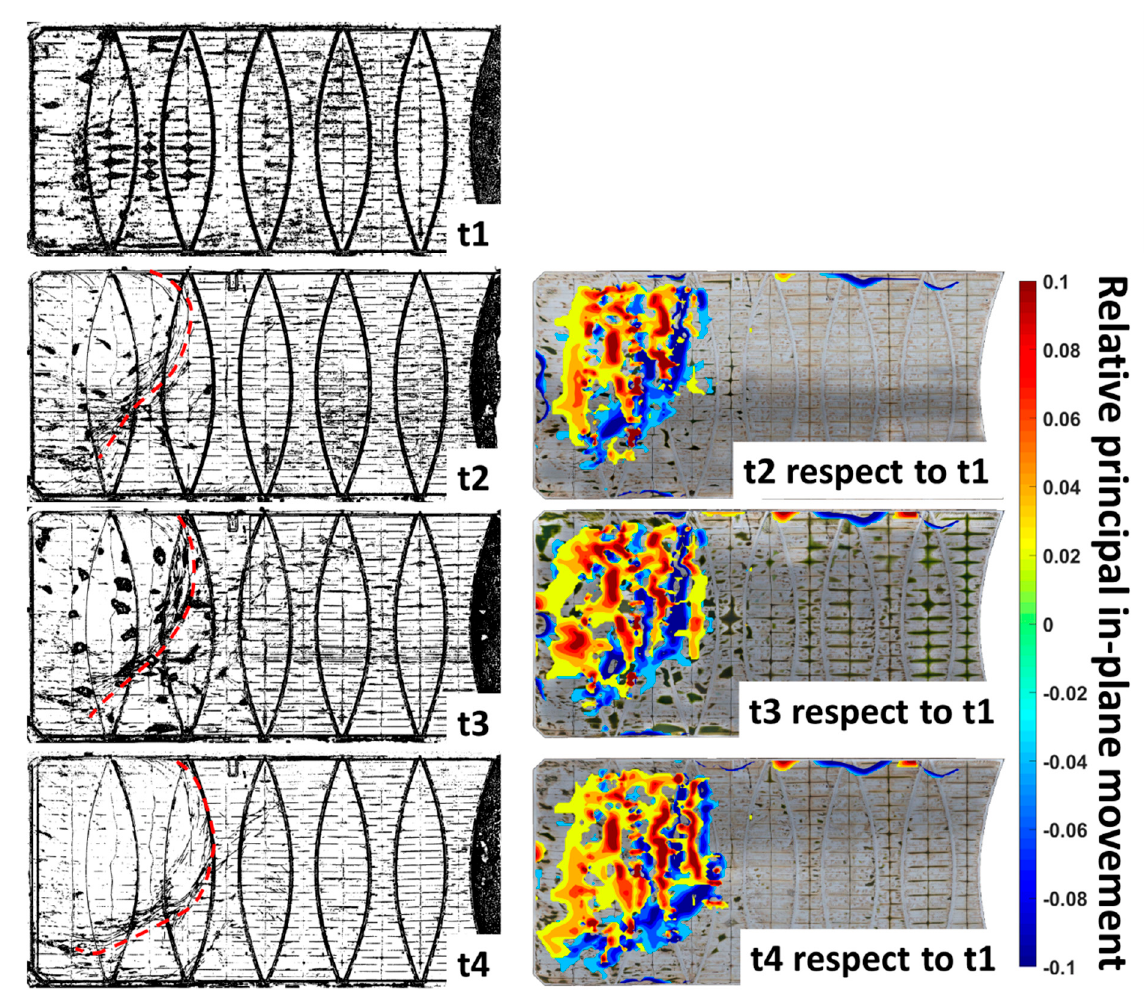
Figure 14. ( left column ) Wrinkles profile (wavefront—red) of floating cover from t1–t4; ( right column ) Principal in-plane movement of floating cover with respect to t1.